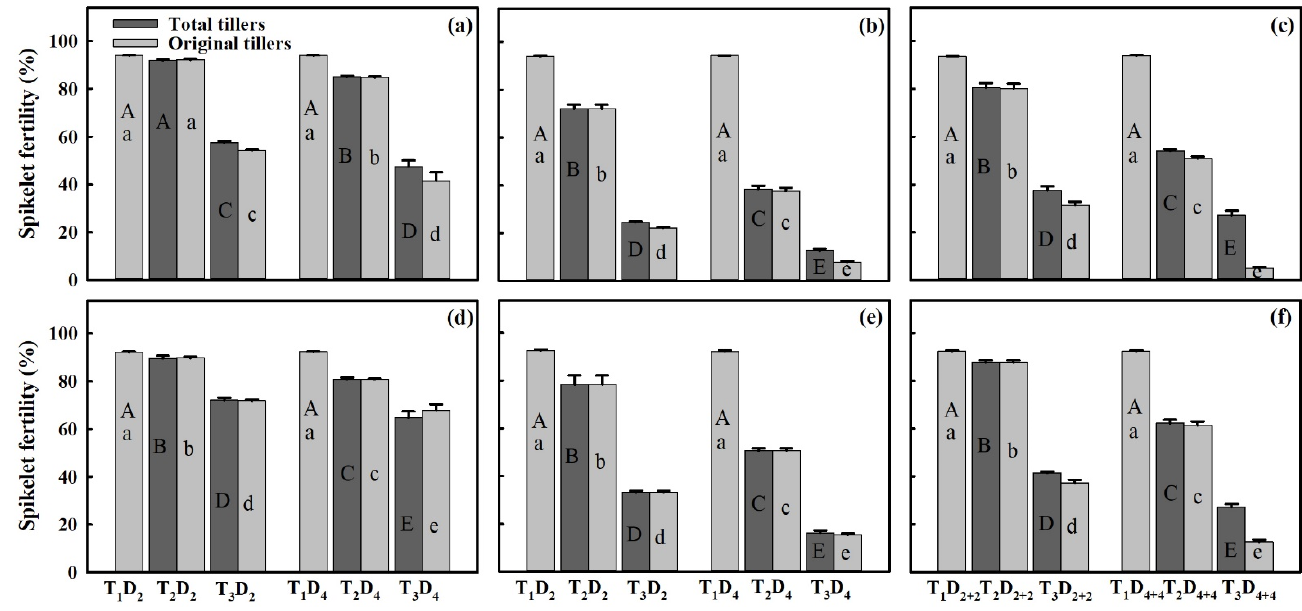
Figure 5. Effects of different high ‐ temperature levels treatments on spikelet fertility including total (original and regenerated tillers) and original tillers of Huaidao ‐ 5 and Wuyunjing ‐ 24 at booting (BT), flowering (FL), and combined (BT + FL) stages. ( a ) Huaidao ‐ 5 at BT treatment; ( b ) Huaidao ‐ 5 at FL treatment; ( c ) Huaidao ‐ 5 at BT + FL treatment; ( d ) Wuyunjing ‐ 24 at BT treatment; ( e ) Wuyunjing ‐ 24 at FL treatment; ( f ) Wuyunjing ‐ 24 at BT + FL treatment. Different uppercase and lowercase letters indicate significant differences at 0.05 level for total and original tillers, respectively. Vertical bars represent the standard deviation of the mean.